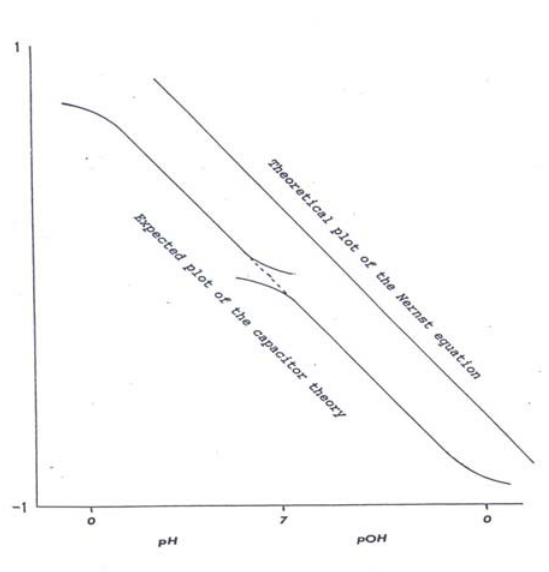
Figure 2. Theoretical and expected plot of the Nerst equation and the capacitor.